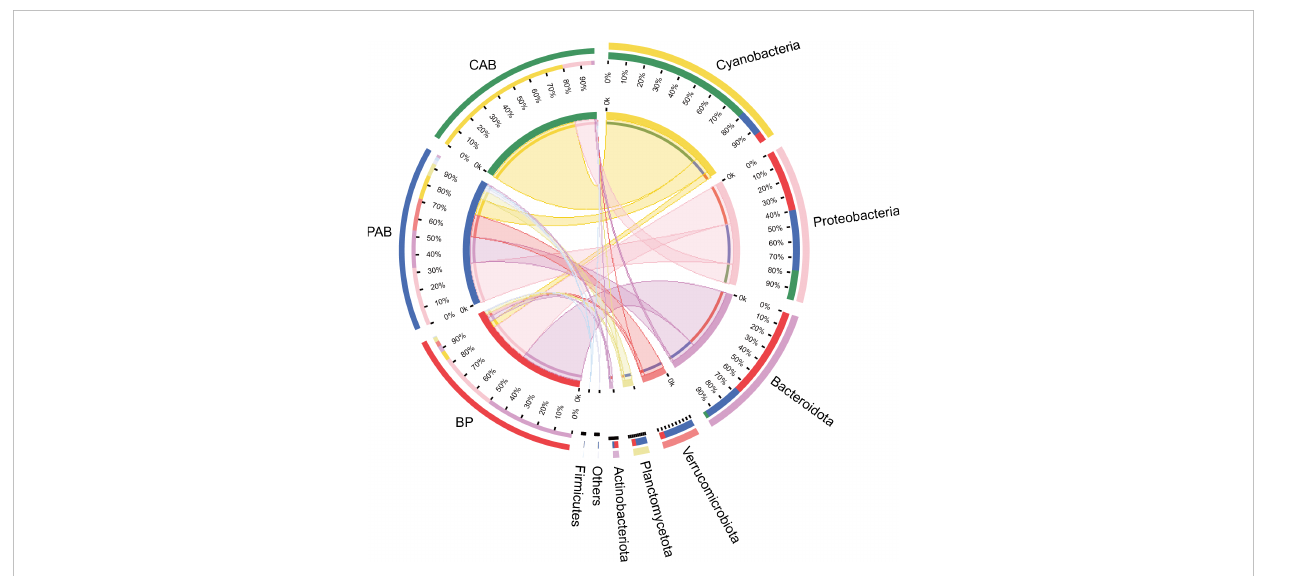
FIGURE 3 Dominant bacterial lineages (top 7 phyla) of BP (bacterioplankton), PAB (particle-attached bacteria), and CAB (colony-attached